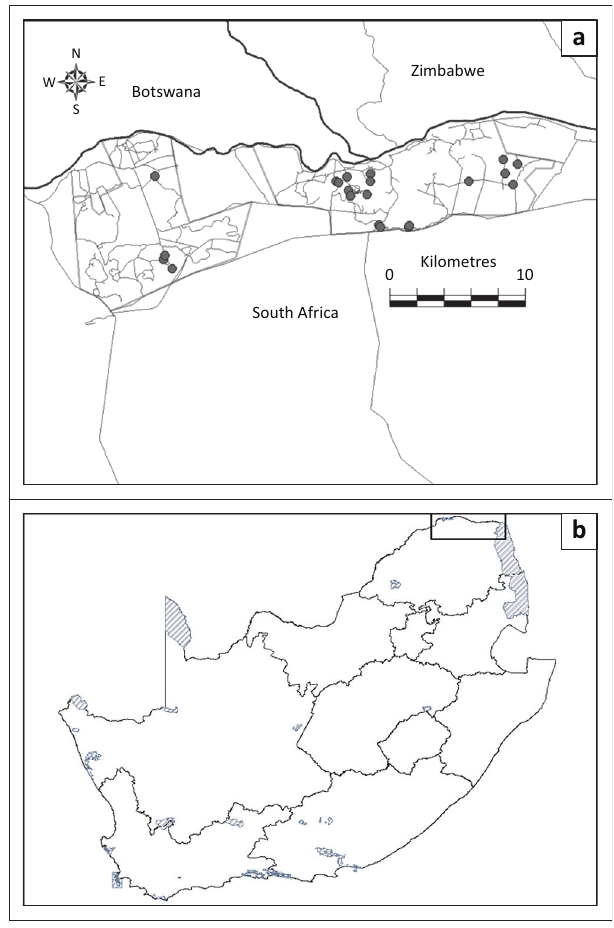
FIGURE 1: Map of the study sites: (a) study area with vegetation transect sites in the Mapungubwe National Park and (b) the position of the Mapungubwe National Park (blocked) within South Africa.